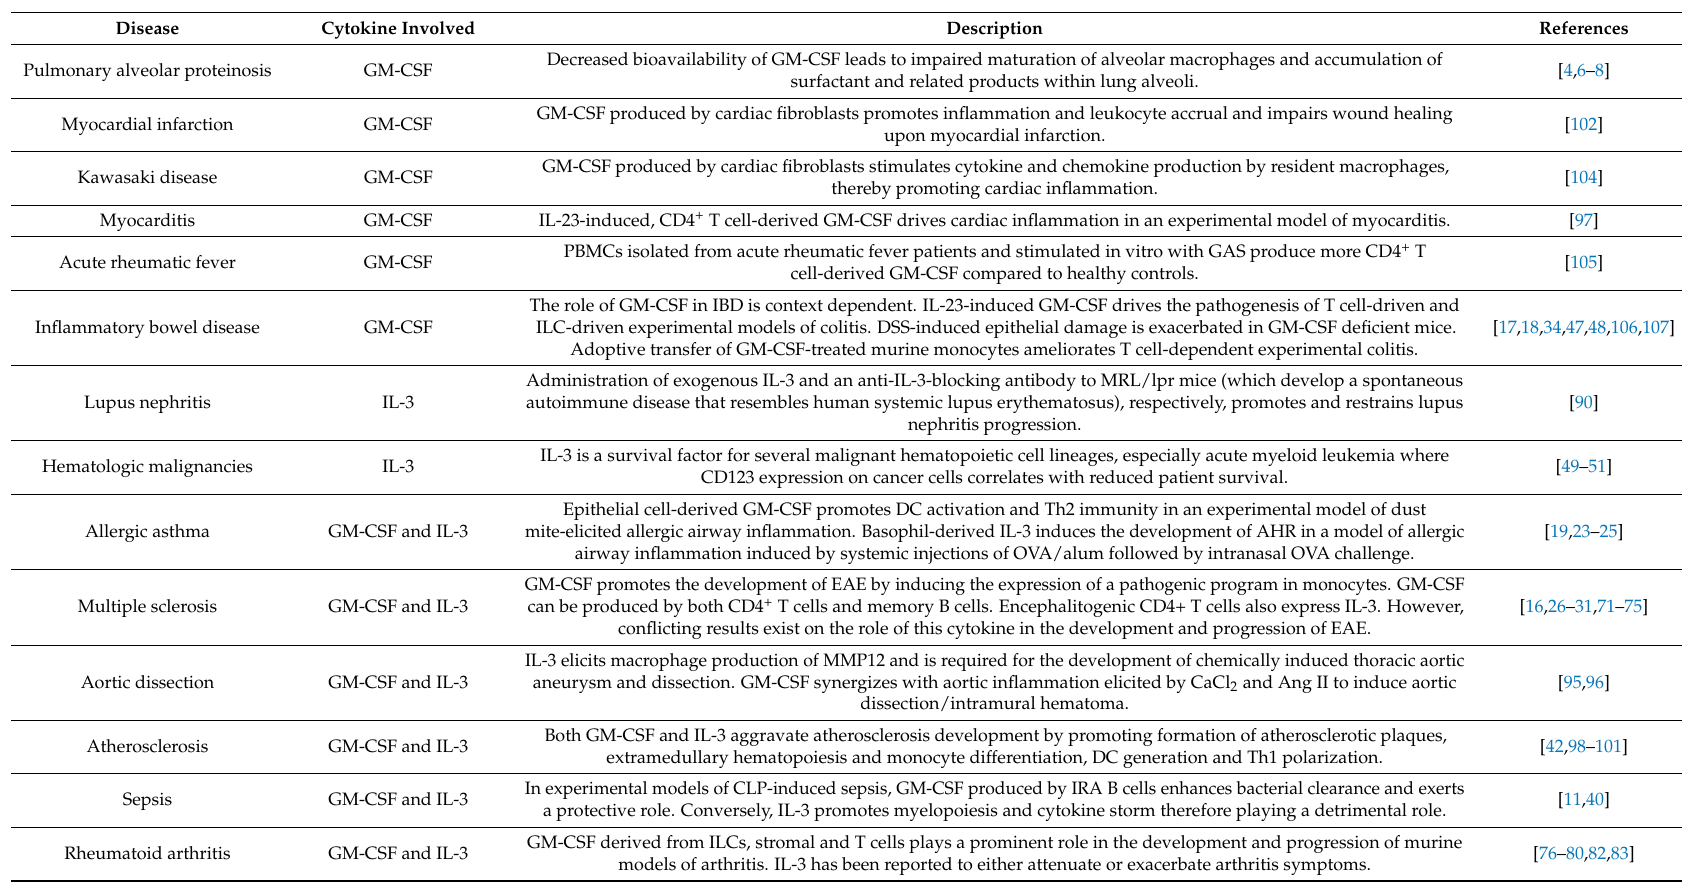
Table 1. Involvement of GM-CSF and IL-3 in disease